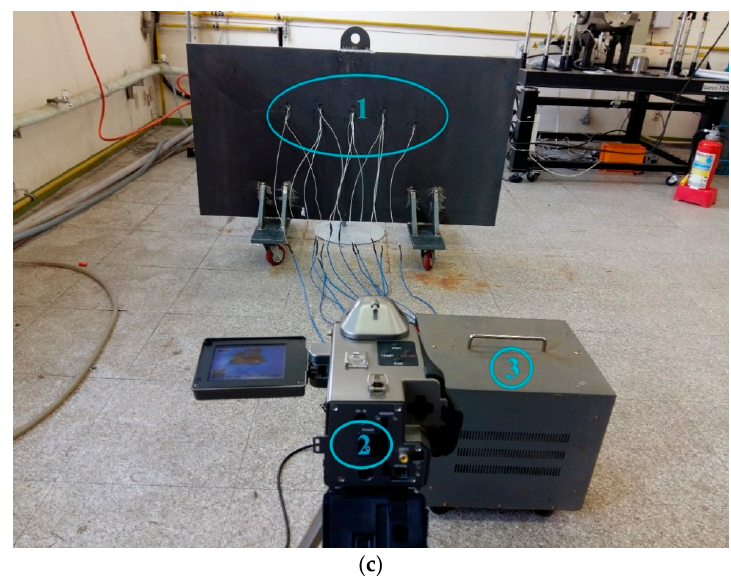
Figure 14. Experimental apparatus setup: ( a ) basic model; ( b ) modified model; ( c ) back side (1: thermocouples, 2: TVS-200EX infrared camera, 3: recorder for thermocouples).